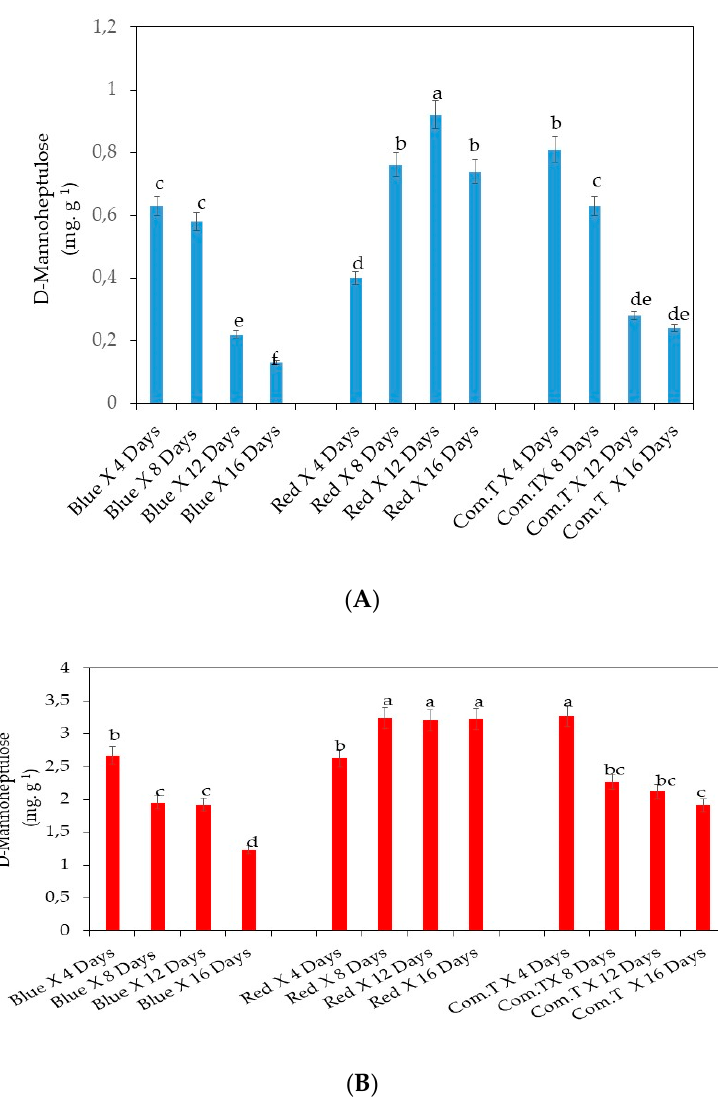
Figure 8. ( A ) Influence of LED lights on D-mannoheptulose and oleic acid content in the mesocarp of avocado cultivar Fuerte. ( B ) Influence of LED lights on D-mannoheptulose and oleic acid content in the mesocarp of avocado cultivar Hass. Mean ± standard deviation values for each bar were calculated based on five fruits. Number of replicates per treatment n = 5. Mean values of bars marked by di ff erent letters were significantly di ff erent at p < 0.05, according to Fisher’s protected LSD test. Blue, blue LED light; Red, red LED light; Com.T, commercial treatment.